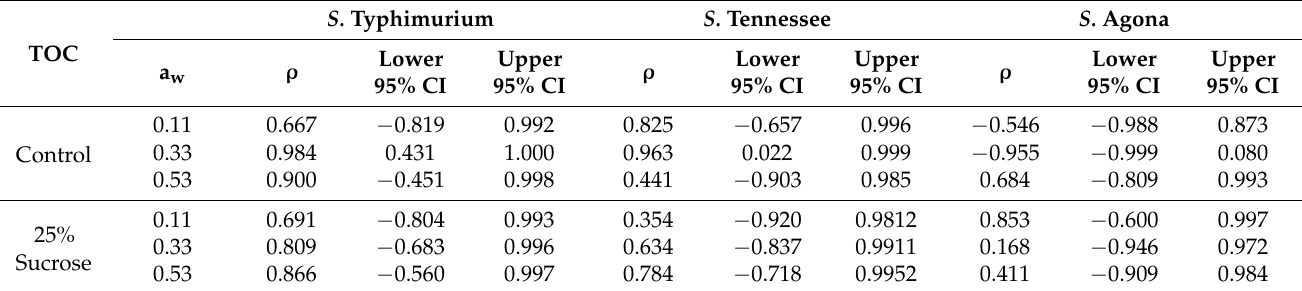
Table 3. Pearson ( ρ ) coefficients of the correlation between temperatures, a w and sucrose content, with the inactivation parameters δ and β of toasted oats cereal (TOC) with and without